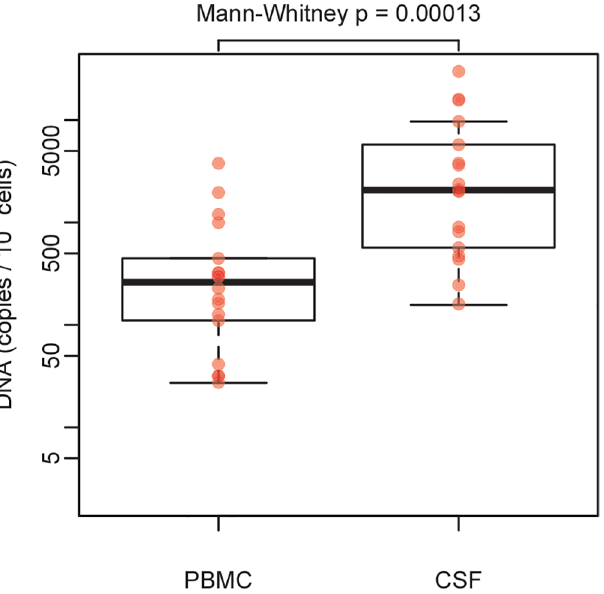
Fig 1. Levels of HIV DNA in PBMC and CSF cell pellets. Comparison of HIV DNA levels between PBMC and CSF cell pellets, among subjects with detectable HIV DNA in both compartments. Rank-based Mann- Whitney test p value is